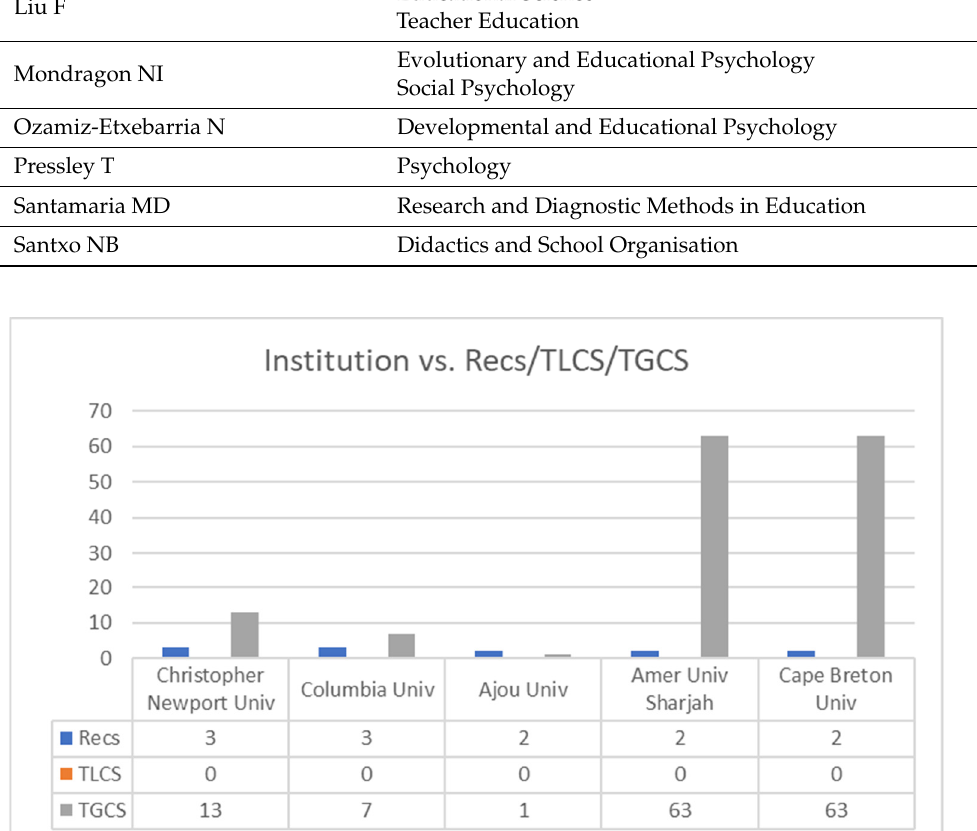
Figure 3. Number of publications by institution ( ≥ 2 Recs; ≥ 12 TGCS). Note: Recs is the number of articles, TLCS is the local citation score and TGCS is the global citation score.